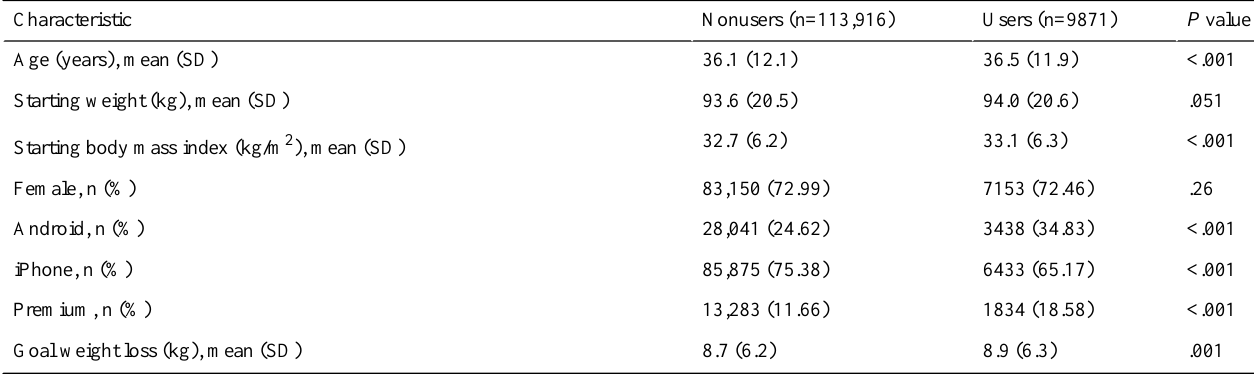
Table 1. Baseline characteristics and comparisons between groups